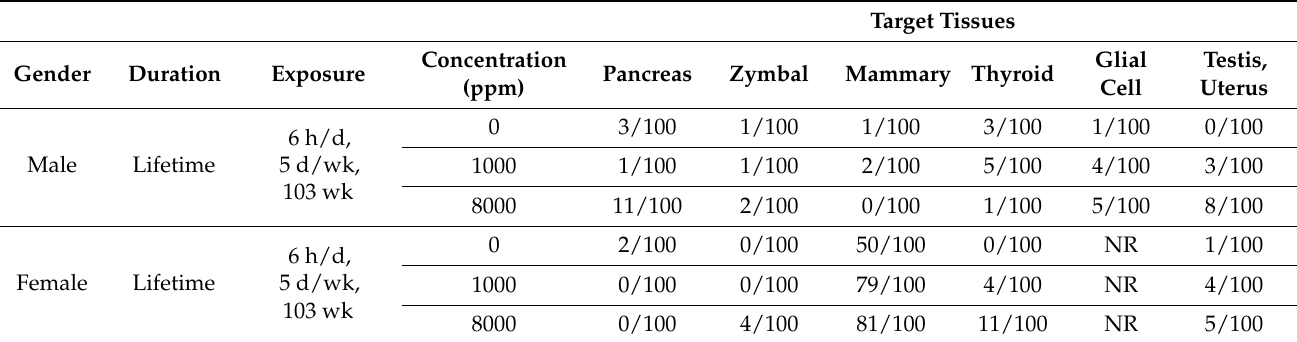
Table 3. Rat tumor data following inhalation exposure to 1,3-butadiene [4,5].